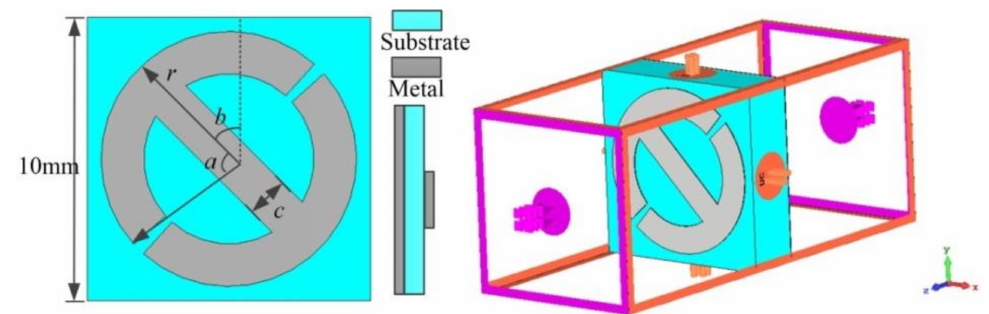
Figure 4. Structure and simulated model of the reflect surface unit